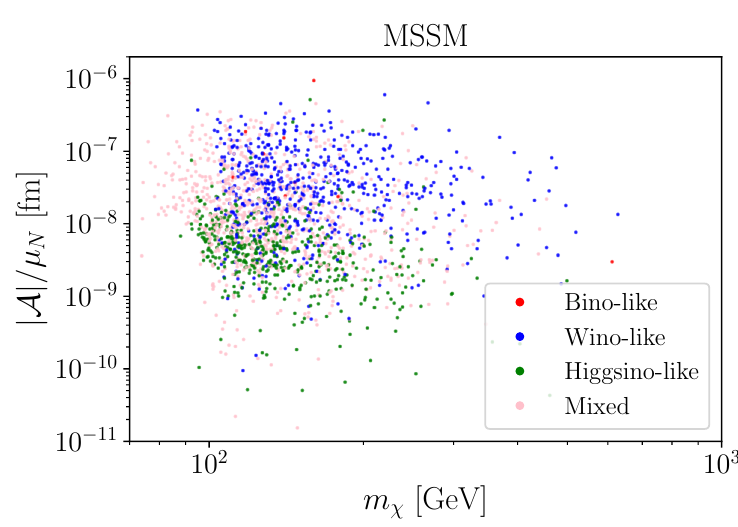
Figure 7. Anapole moment for MSSM scenarios with parameters in the ranges listed in table 1 and satisfying the experimental constraints discussed in subsection